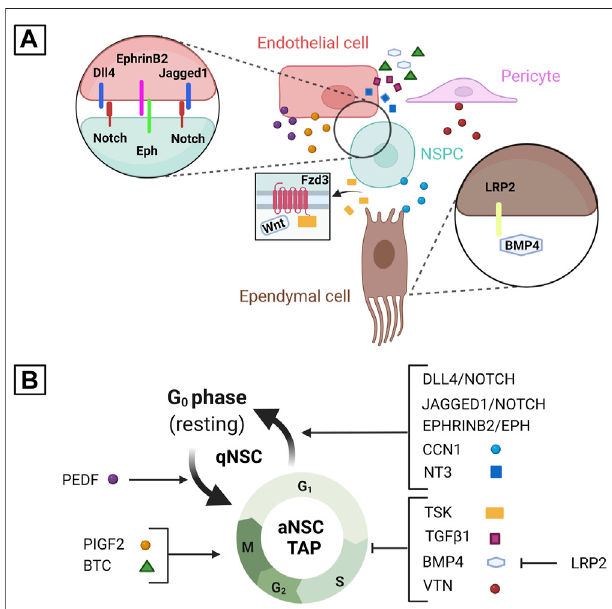
FIGURE 3 | Schematic representation of some of the juxtacrine and paracrinesignalsmediatingtheregulationofV-SVZNSPCsbyependymaland vascularcells. (A) showssomeofthesignalsandreceptorsproducedbyeach cell type (endothelial cells, pericytes, ependymal cells and NSPCs). (B) shows the role of each signal in the regulation of NSC activation or NSPC proliferationbasedonthestudiesdescribedinthisreview.Inparticular,CCN1, Dll4,Jagged1,ephrinB2,andNT3areinvolvedinpromotingNSCquiescence, whereas PEDF is involved in promoting NSC activation; PlGF2 and BTC are involved in promoting NSPC proliferation, whereas TSK, TGF β 1, BMP4, and VTN are involved in inhibiting it. LRP2 is involved in promoting NSPC proliferation indirectly by inhibiting BMP4 activity. TSK may affect NSPC proliferation by binding Fzd3, a Wnt receptor, and modulating Wnt signaling. Please note that some of these molecules may play multiple roles in the regulationofNSCactivation/quiescenceandofNSPCproliferationthatarenot represented in this diagram. See text for further details. Created with